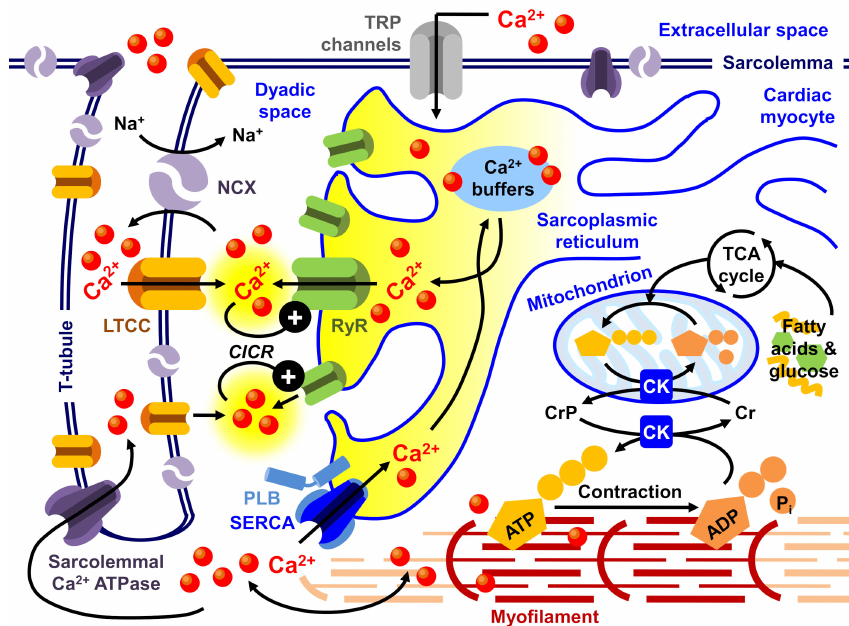
Figure 1. Schematic of excitation–contraction (EC) coupling in cardiac myocyte. Ca 2+ , calcium; CIRC, Ca 2+ -induced Ca 2+ release; SERCA, sarcoplasmic/endoplasmic reticulum Ca 2+ ATPase; PLB, phospholamban; RyR, ryanodine receptor; NCX, sodium–calcium exchanger; LTCC, L-type Ca 2+ channel; TRP channels, transient receptor potential channels; TCA, tricarboxylic acid (Krebs) cycle; CrP, creatine phosphate; CK, creatine kinase